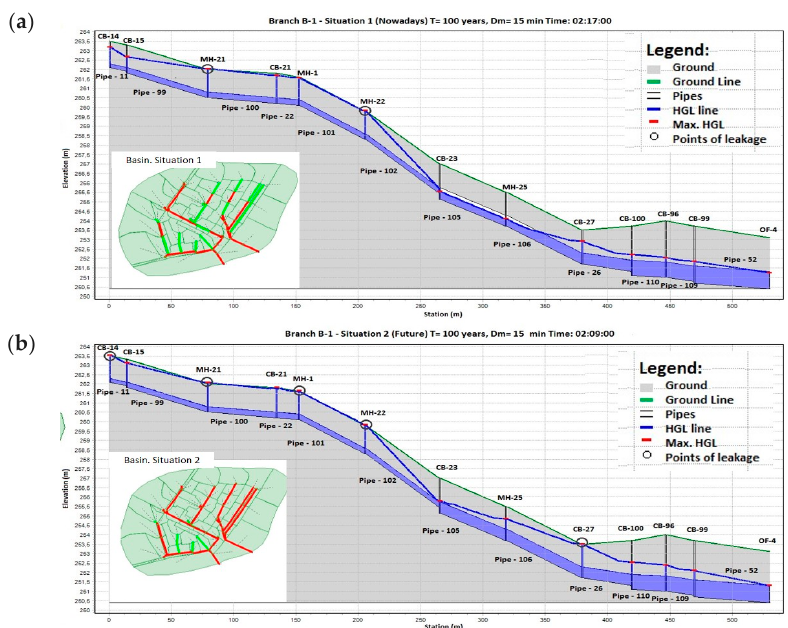
Figure 5. Representation of the network and profiles of the main pipe branch for Scenarios 1 and 2 ( T = 100 years and D m = 15 min), ( a ) Scenarios 1 (nowadays) and ( b ) Scenarios 2 (future). With the application of the conjugated green roofs and impervious paving, for an occupation of 30% of the total impermeable area (Scenario 3), the maximum reduction in the peak flow is 0.25 m 3 /s, which equals a reduction of 20% of the registered value in Scenario 2. For an occupation of 50% in the impervious areas (Scenario 4), the maximum reduction in the peak flow is 0.34 m 3 /s, which equals a 27% reduction. For occupations of 70% and 90% (Scenarios 5 and 6), the maximum reductions in the peak flow are 0.38 m 3 /s and 0.37 m 3 /s, respectively, corresponding to 28% reductions in the peak flow in both cases.